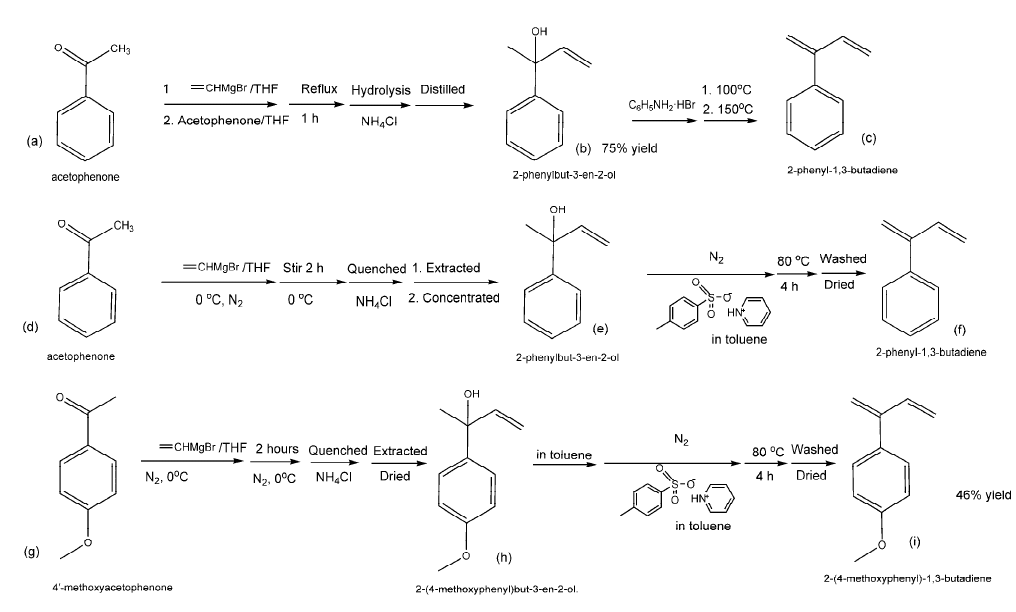
Figure 8. Synthesis of 2-phenyl-1,3-butadiene [115–119].